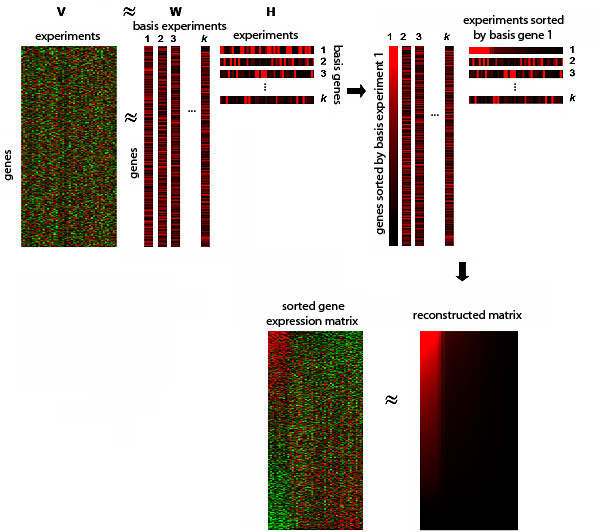
General schema of the method nsNMF approximates the original matrix as a product of two submatrices, W and H. Columns of W are basis experiments while rows of H constitute basis genes (columns of W and rows of H are separated for a better visibility). Coefficients in each pair of basis gene and experiment are used to sort conditions and genes in the original matrix. Conditions and genes with high values in the same basis gene and basis experiment are highly related in a sub-portion of the data and are co-clustered in the upper left corner of the sorted array.